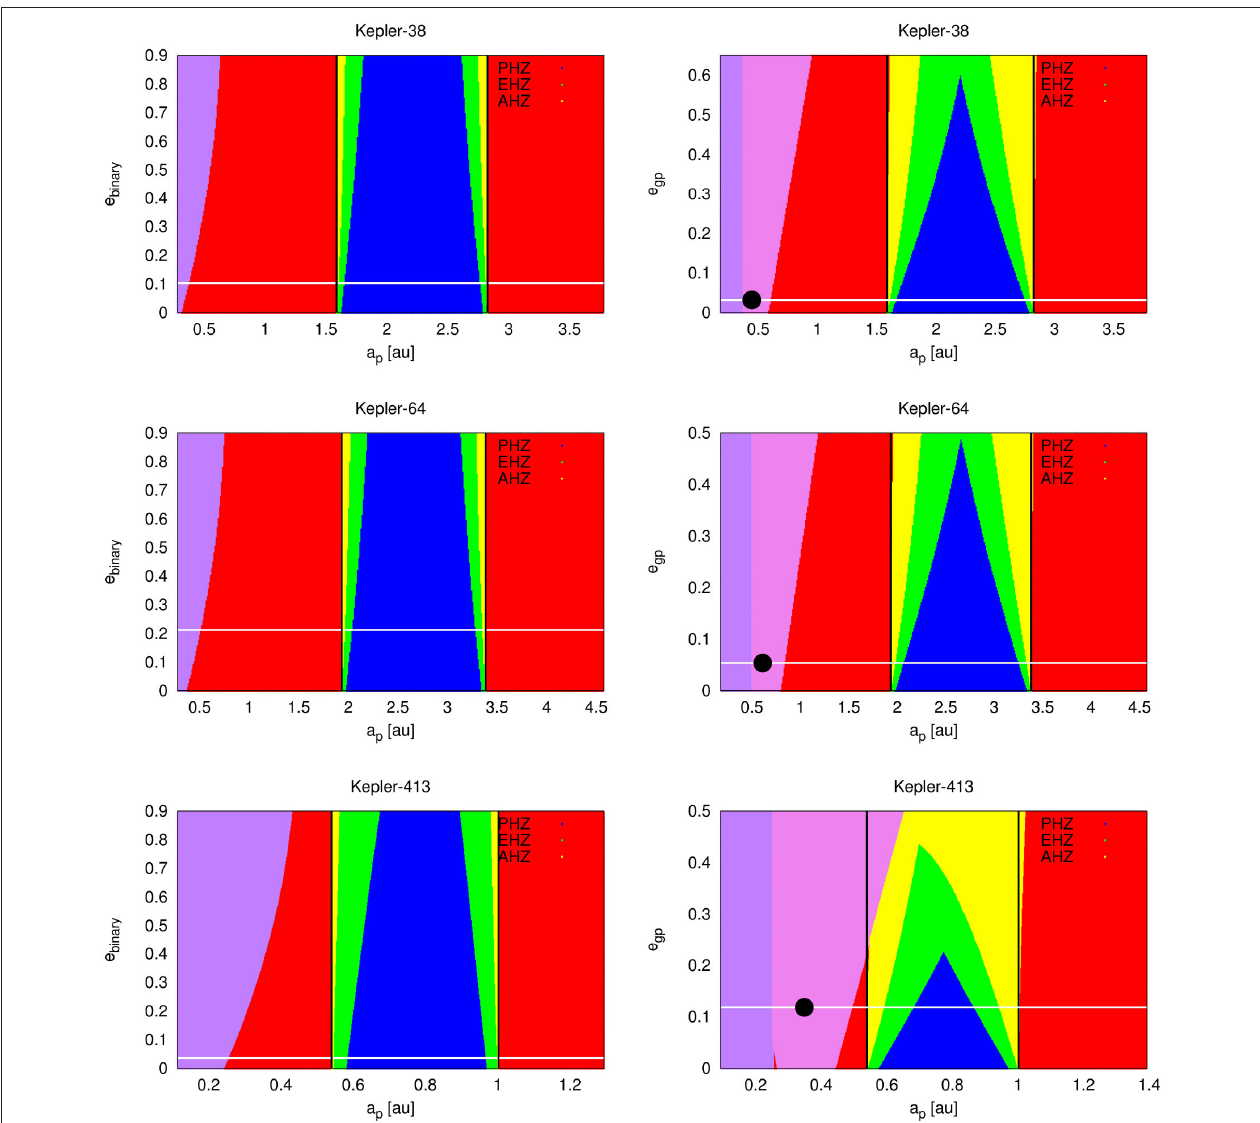
FIGURE 4 | Same as Figure 3 for Kepler-38, Kepler-64, and Kepler-413.